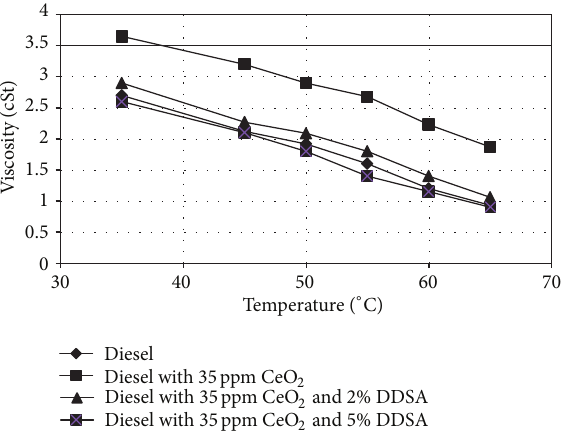
Figure 8: Variation of the brake thermal efficiency with load.